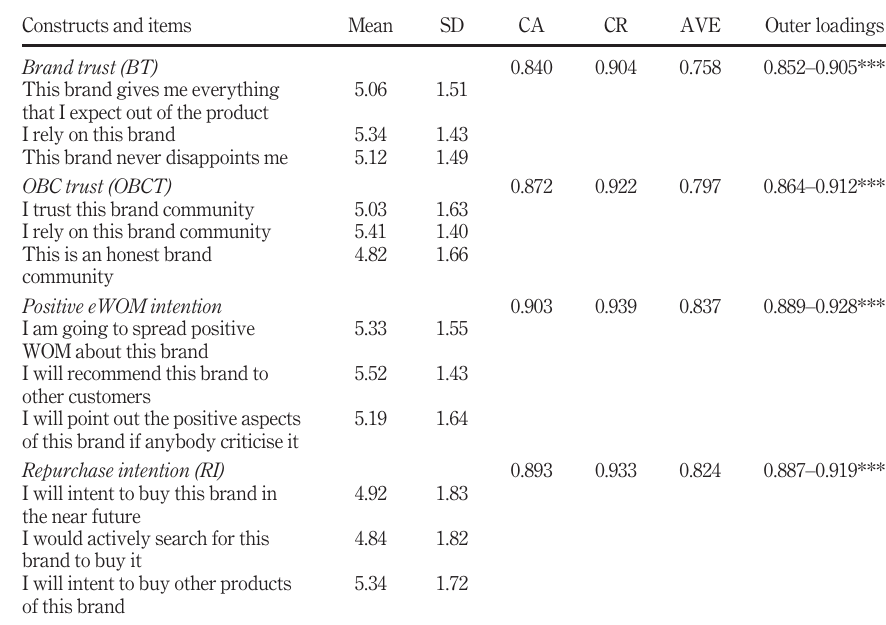
Table 1. Assessment of the measurement model and